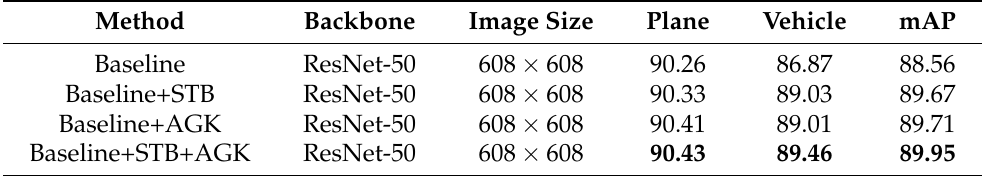
Table 3. Results of ablation studies on different components. +STB means that we add the proposed semantic transfer block to the baseline network. +AGK means that we replace the Gaussian heatmap in the baseline with an adaptive Gaussian heatmap generated by the adaptive Gaussian kernel. Bold numbers in the table mean the best